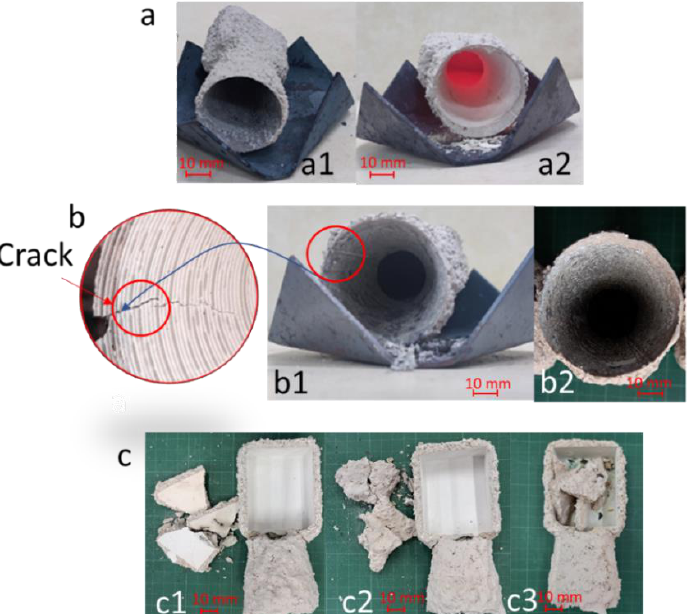
Figure 5. The outer shells were obtained using ( a ) PLA – , ( b ) PVB – , and ( c ) CW – printed patterns. The number ( 1 ), ( 2 ), and ( 3 ) in the figure indicated the fast, slow, and multi – step heating processes, respectively.